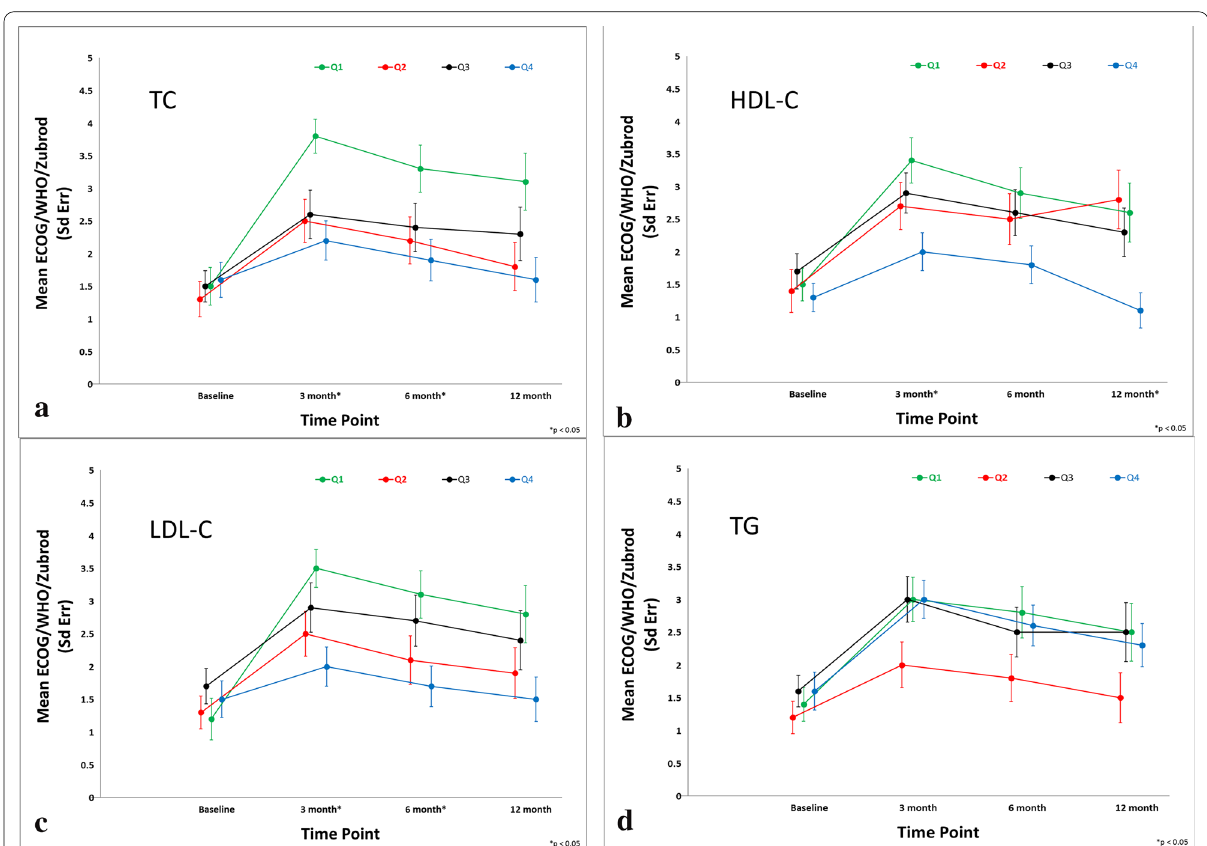
Fig. 1 Quartiles of ECOG/WHO/Zubrod score plotted at baseline, 3, 6, and 12 months for: a TC (total cholesterol), b high-density lipoprotein-cholesterol (HDL-C), c low-density lipoprotein-cholesterol (LDL-C), d triglycerides (TG), e HDL inflammatory index (HII), f paraoxonase-1 (PON-1), g apolipoprotein A-I (ApoA-I), and h myeloperoxidase (MPO). Differences at each time point are represented by colored lines for lipid biomarker quartiles with standard error bars, with asterisks indicating significant differences per